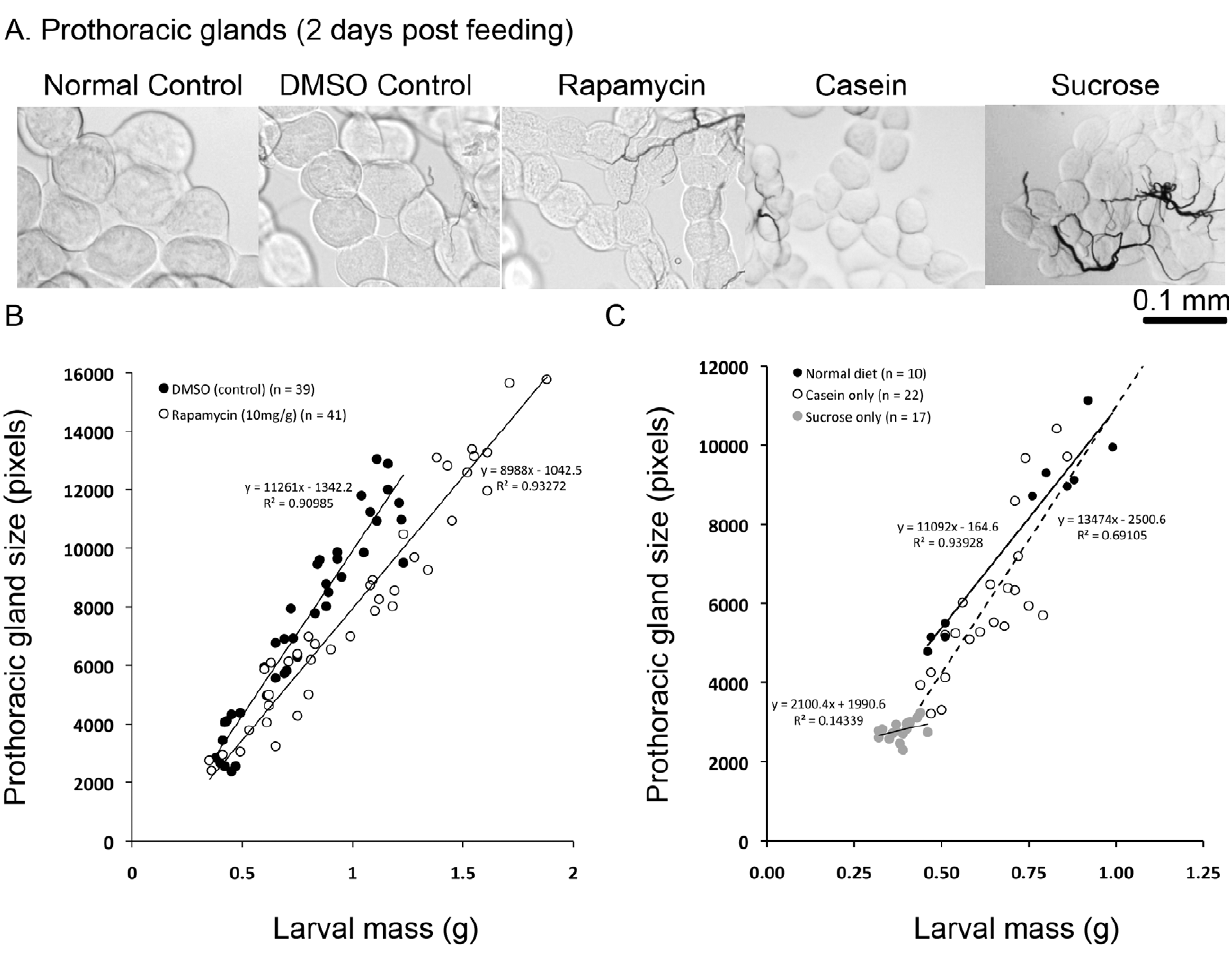
Figure 4. Effect of rapamycin and various nutrients on prothoracic gland growth. (A) Representative prothoracic glands, two days post feeding diets containing various nutrients. (B,C) Effect of rapamycin (B) and various nutrients (C) on prothoracic gland growth relative to body size. Prothoracic glands were dissected out from larvae at various weights. The size of prothoracic glands was determined by measuring the cross- sectional area of the glands. Larvae were transferred to the treated diets after being fed a non-nutritive diet for two days post head capsule slip at the end of the third instar. The glands were dissected after the larvae were fed the respective diets for at least one day.